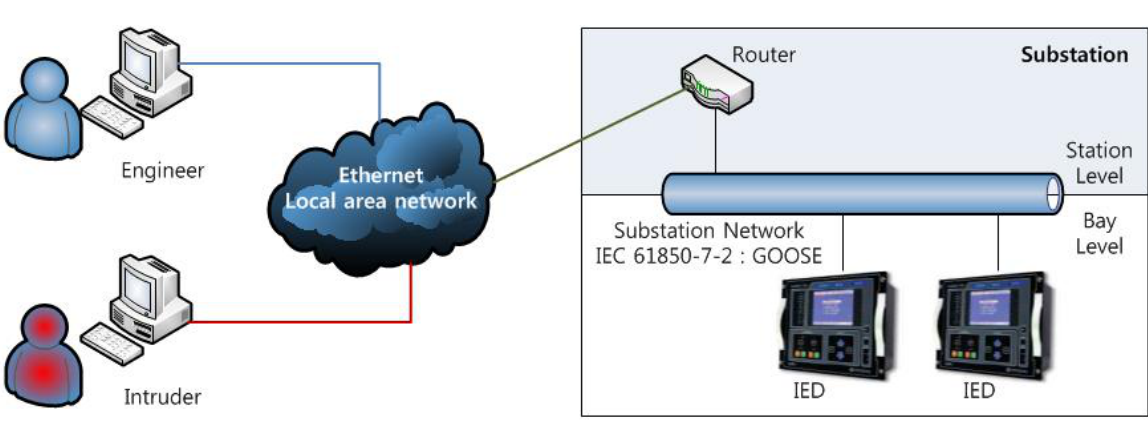
Figure 1. Attack test